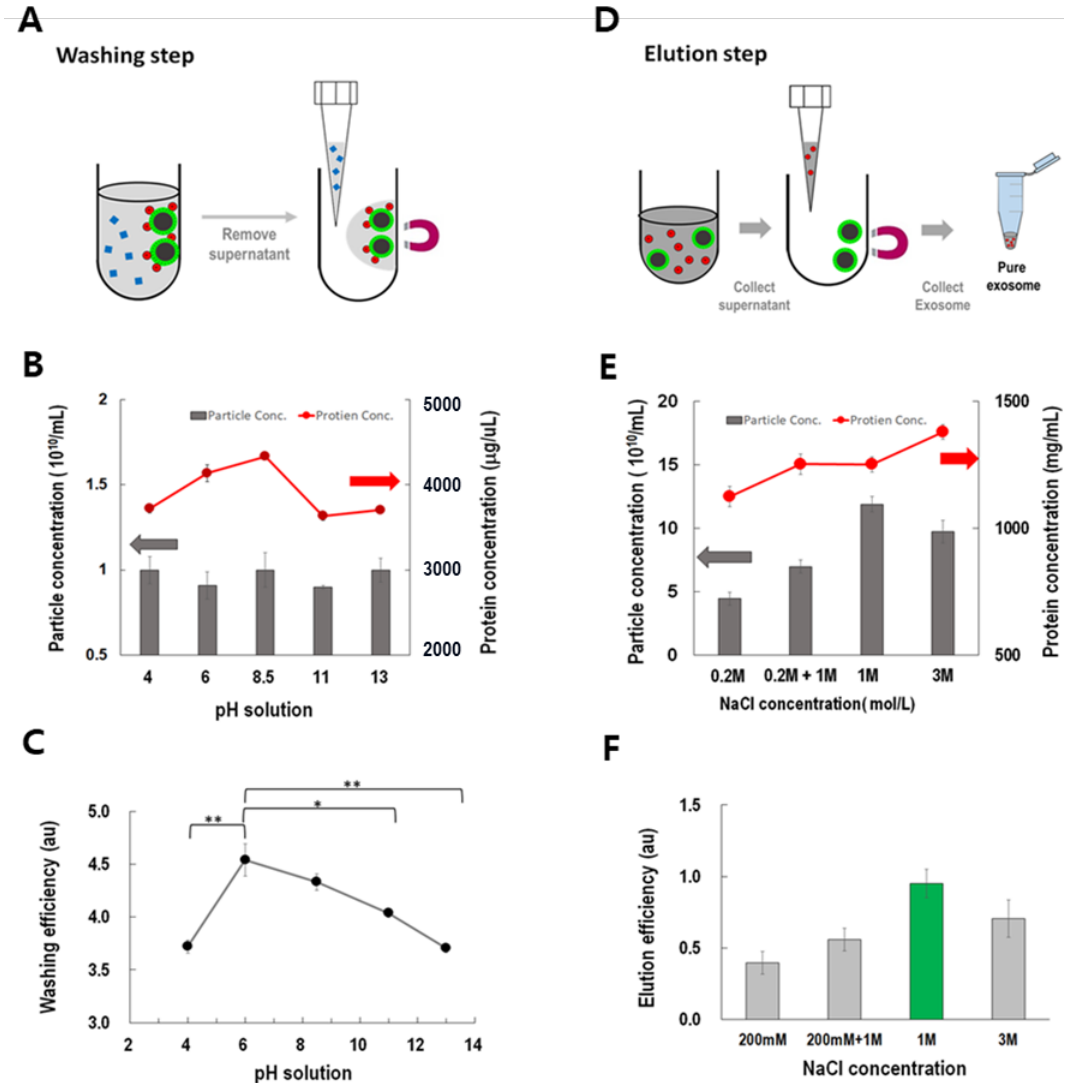
Figure 5. Optimization of washing and eluting processes under the current PLL-coated magnetic bead-based ion exchange method. ( A ) Washing step to remove undesired proteins. ( B , C ) Particle concentration, protein concentration, and washing efficiency (protein/particle ratio) in the washing step (*: p < 0.05, **: p < 0.01). ( D ) Elution step to collect pure exosomes. ( E , F ) Particle concentration, protein concentration, and elution efficiency (particle/protein ratio) in the elution step. (Grey arrow: the coordinates of the bar in the figure; Red arrow: the coordinates of the line in the figure)